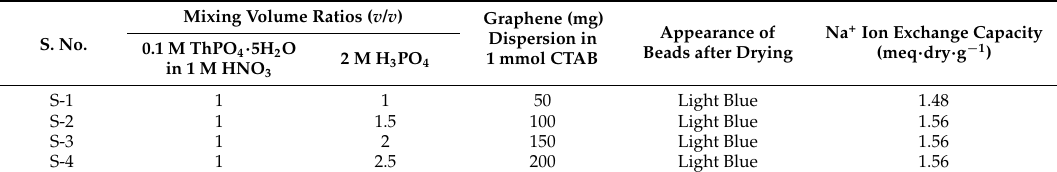
Table 1. Conditions of preparation and the ion-exchange capacity of graphene Th(IV) phosphate composite cation-exchange material. CTAB: N-cetyl-N,N,N-trimethylammonium bromide. S. No.